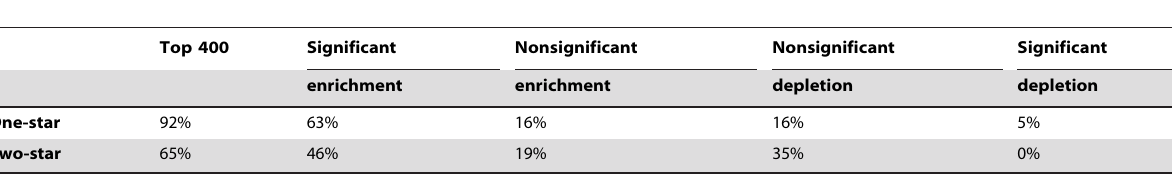
The table indicates the percentage of cases for which at least one correct structure is selected in the top 400, and the percentage of complexes of which the number of correct structures is higher than random selection (enrichment) or lower than random selection (depletion). Significance (p , 0.05) was determined using the hypergeometric distribution. One-star and two-star criteria correspond to the CAPRI [18] definitions (see Material & Methods). For one-star structures, only those complexes are considered with at least 10 one-star solutions among the 10 000 (63% of all complexes). For two-star structures, only those complexes are considered with at least one two-star solution (44% of all complexes). The fnat criterion is not taken into account.